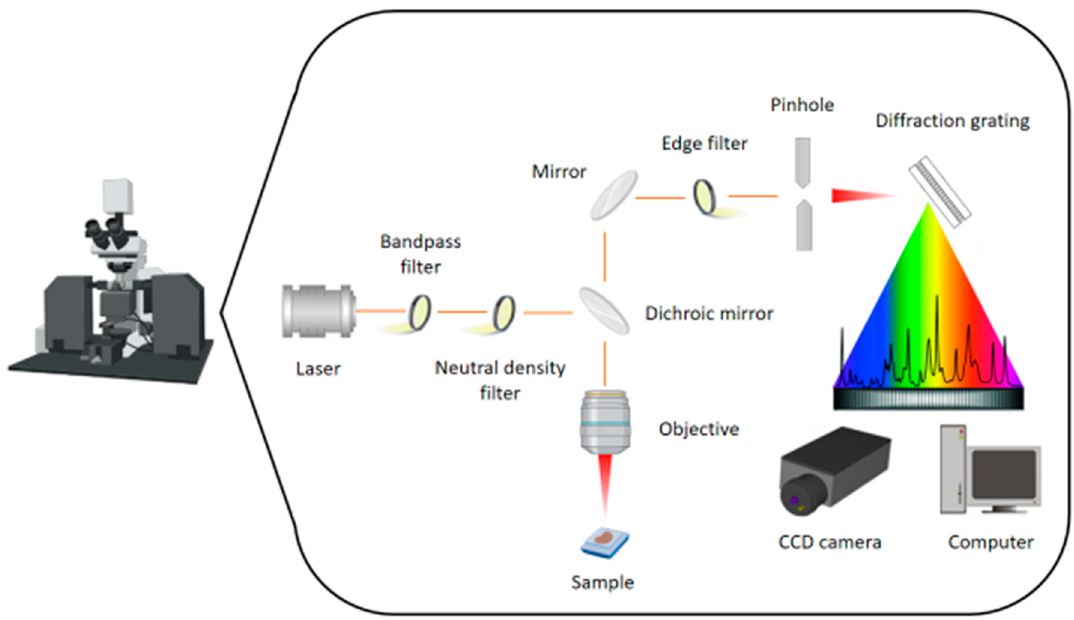
Figure 1. Schematic overview of a Raman microscopy/spectroscopy setup .